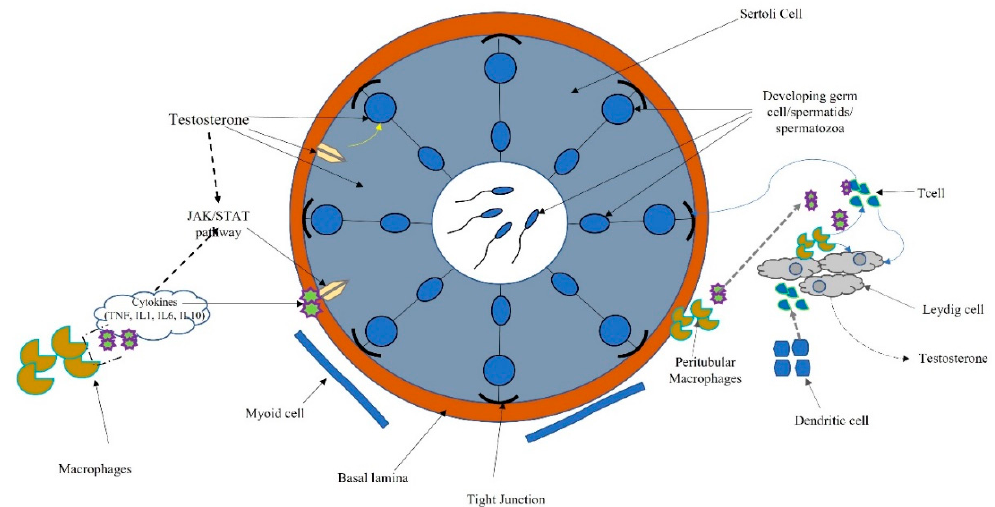
Figure 3. Schematic connection between immune system, cytokines, and hormonal pathways in testicular function and regulation.